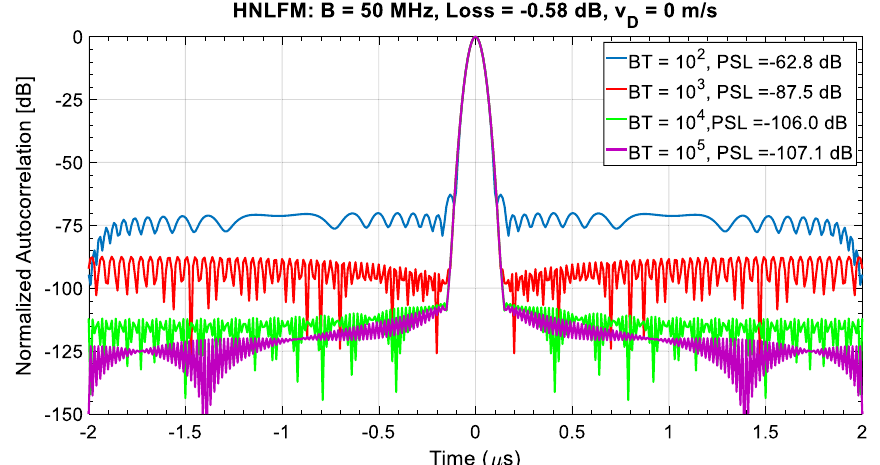
Fig. 3 Normalized ACF in decibel (dB) of a HNLFM waveform with varying BT (no Doppler shift, perfect generation and reception)